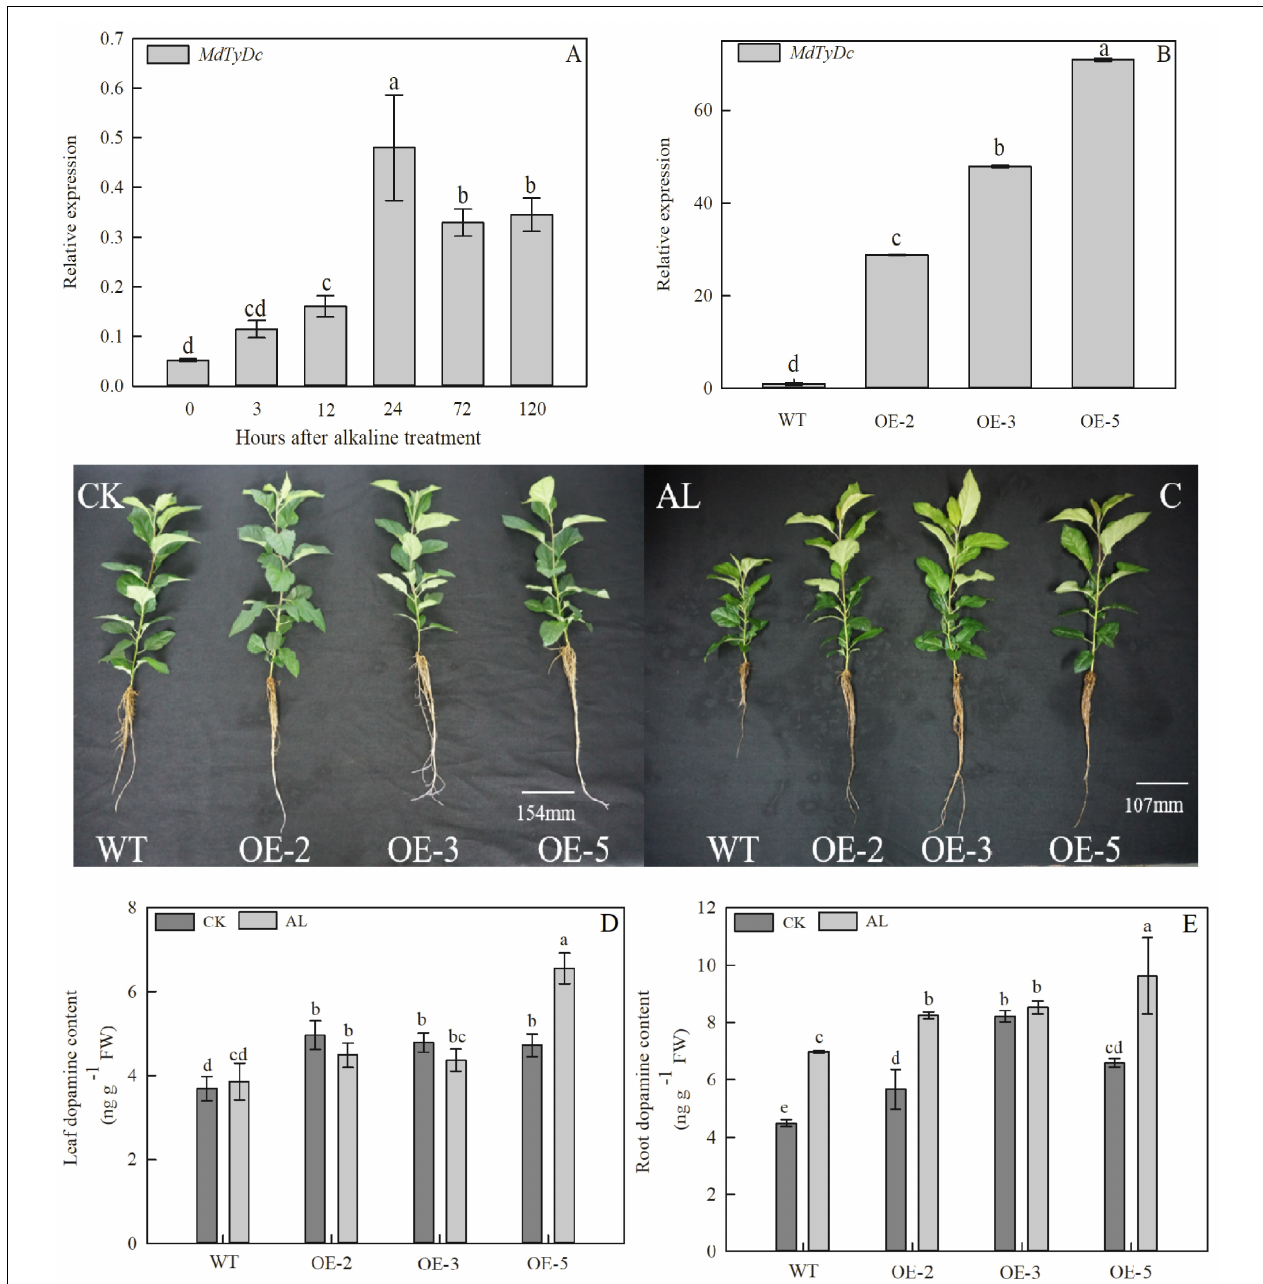
FIGURE 1 | Overexpression of MdTyDc confers enhanced alkaline tolerance to apple. (A) The expression of MdTyDc after alkaline treatment in GL-3 apple; (B) qRT–PCR analysis of MdTyDc transcripts in lines WT, OE-2, OE-3, and OE-5; (C) the phenotype and dopamine content of MdTyDc -overexpressing apple plants in (D) leaves and (E) roots after 15 days under control and alkaline conditions. The data are presented as means ± SD ( n = 3). Significant differences between WT and MdTyDc overexpression lines are indicated by different lowercase letters based on Tukey’s multi-range test ( P < 0.05). WT, wild type. OE-2, MdTyDc overexpression line 2. OE-3, MdTyDc overexpression line 3. OE-5, MdTyDc overexpression line 5.